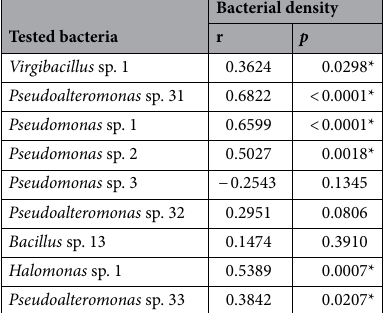
Table 2. Correlation analysis between BF cell density of deep-sea bacteria and inductive efficiency. r = Spearman’s rank order correlation analysis; p : p -value; *: significant at p < 0.05.